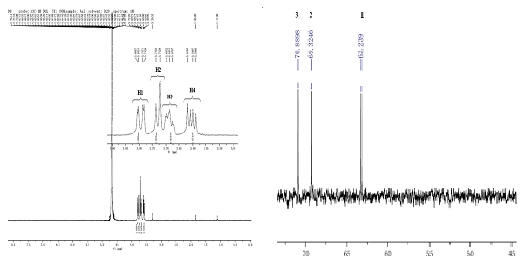
Fig.2. l H and l3 C NMR spectral data of mannitol ( 1